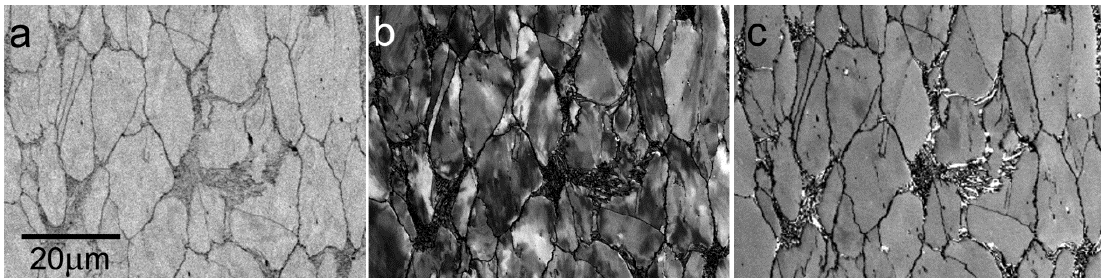
Figure 15. The X210Cr12 steel heated to semi-solid state at 1265  C, deformed 2:1 at 800  C and cooled. ( a ) Standard BSE image at 6 keV; ( b ) Sample immersed in 900 V/mm, landing energy 500 eV; ( c ) Sample immersed in 1 kV/mm, landing energy 50 eV.